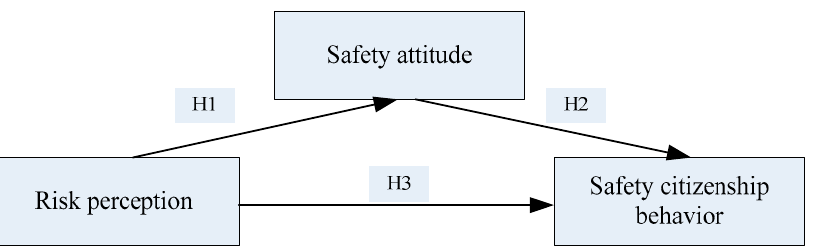
Figure 1. Framework of the influence model and the hypotheses among safety citizenship behavior, safety attitude and risk perception.